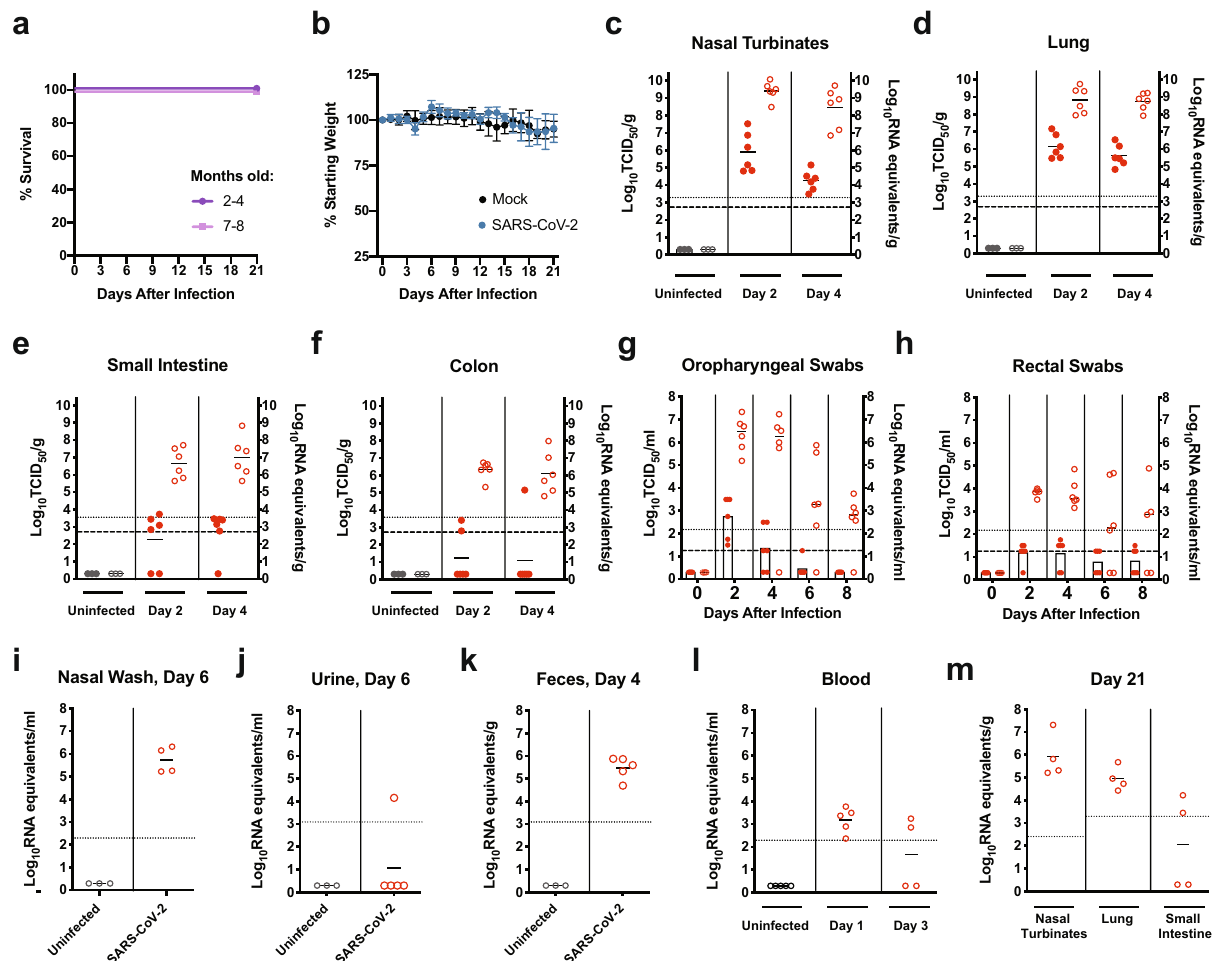
Fig. 2 SARS-CoV-2 infection of adult deer mice. a – m Eight to thirty two-week old female or male deer mice ( P. maniculatus ) were inoculated with 10 5 TCID 50 or 10 6 TCID 50 of SARS-CoV-2 by an intranasal route (i.n.) of administration and compared with age-matched uninfected controls. A summary table outlining the experimental design for the infection studies with reference to the corresponding fi gure panels is provided (Supplementary Table. 1). Solid lines indicate mean, error bars indicate SD. Dashed lines and dotted lines indicate the limit of detection for the TCID 50 assay and qRT-PCR assay, respectively. a , b , Kaplan – Meier curve depicting survival data ( a ) and weight data ( b ) over the course of 21 days following SARS-CoV-2 exposure (challenge dose, 10 5 TCID 50 ). c – f , Infectious viral load ( fi lled in circles, left axis) and vRNA levels (empty circles, right axis) in the ( c ) nasal turbinates, ( d ) lung, ( e ) small intestine, and ( f ) colon (challenge dose, 10 5 TCID 50 ). g , h , Infectious viral load ( fi lled in circles with bars, left axis) and viral RNA levels (empty circles, right axis) in ( g ) oropharyngeal swabs and ( h ) rectal swab samples (challenge dose, 10 5 TCID 50 ). i , Viral RNA levels in nasal washes at 6 dpi (infectious dose, 10 5 TCID 50 ). The sample was obtained for 4/5 deer mice. j – l , Viral RNA levels in the ( j ) urine, ( k ) feces, and ( l ) blood at the indicated times postinfection (infectious dose, 10 6 TCID 50 ). m , Viral RNA levels in the nasal turbinates, lung, and small intestines at 21 days postinfection (infectious dose, 10 5 TCID 50 ). Data were collected from two independent experiments. ( a , b , n = 6; c – f , n = 3/6, for uninfected/infected; g , h , n = 5/6; i – k , n = 3/4 ( i ) or 3/5 ( j , k ), for uninfected/infected; l , n = 5 (uninfected, 1 dpi) or 4 (3 dpi); m , n = 4 biologically independent samples (individual animals) were